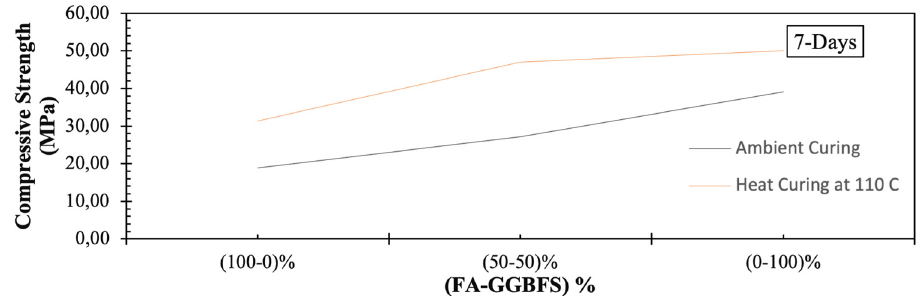
Figure 3: The e ff ect of binder ratio and curing condition on the compressive strength at 7 days.